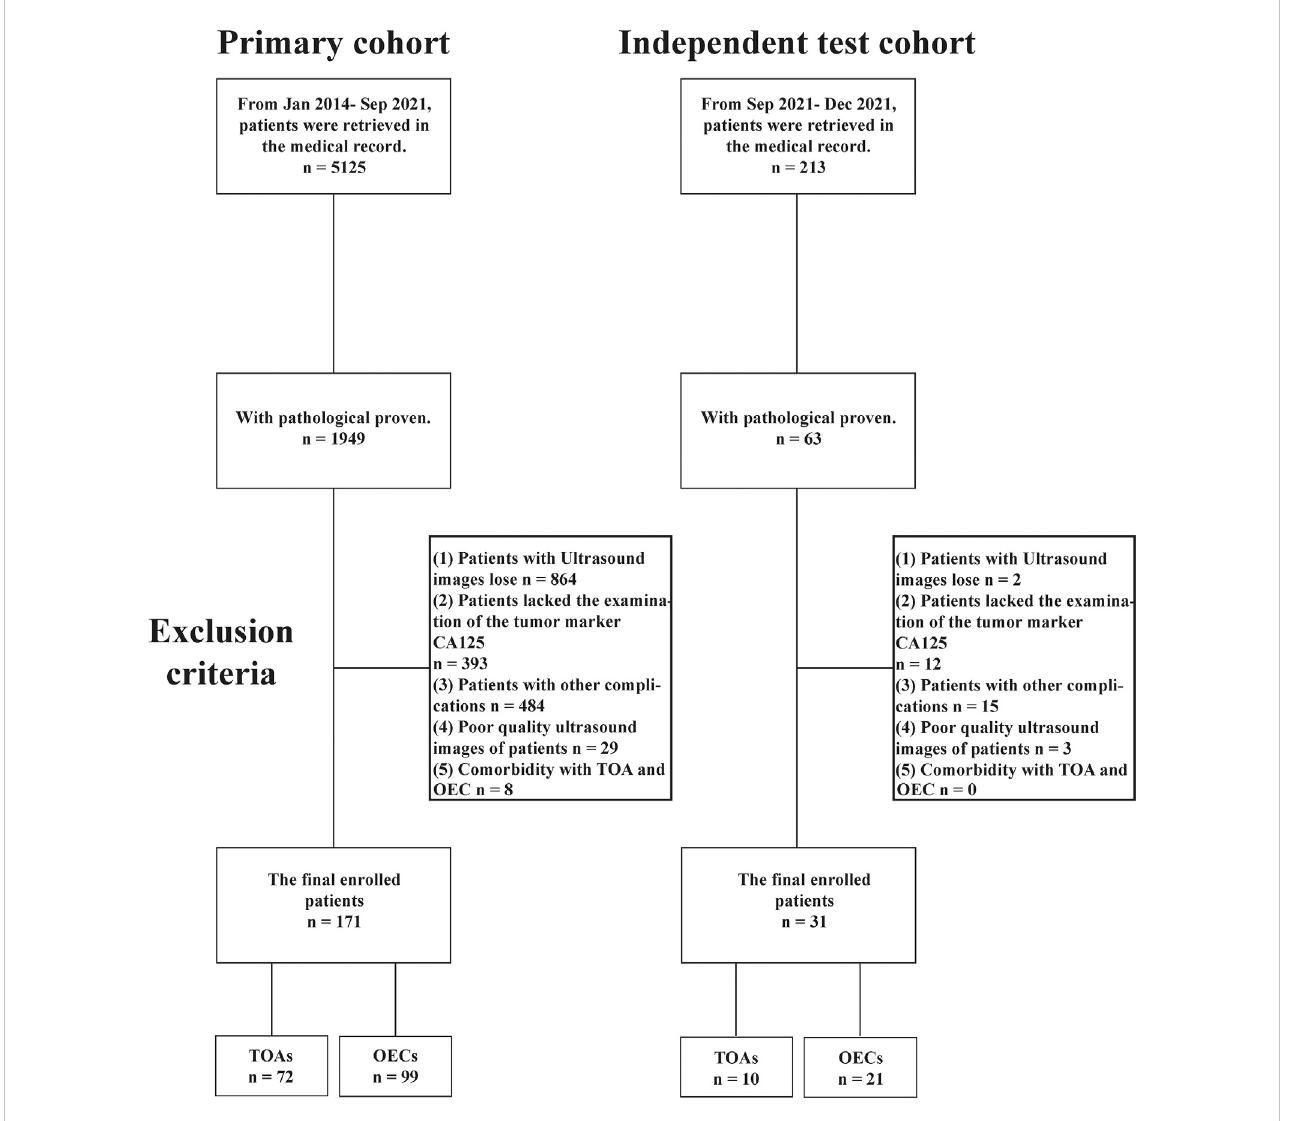
FIGURE 1 Inclusion work fl ow of subjects in this